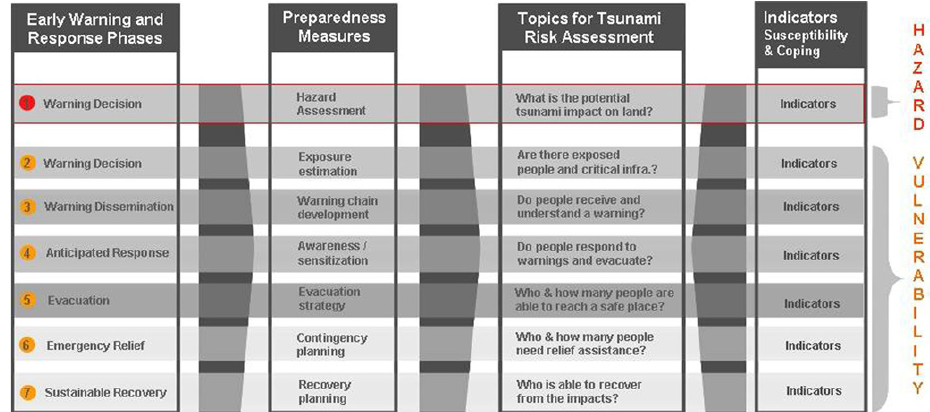
Fig. 1. Conceptual vulnerability framework of GITEWS (Post et al., 2009c).